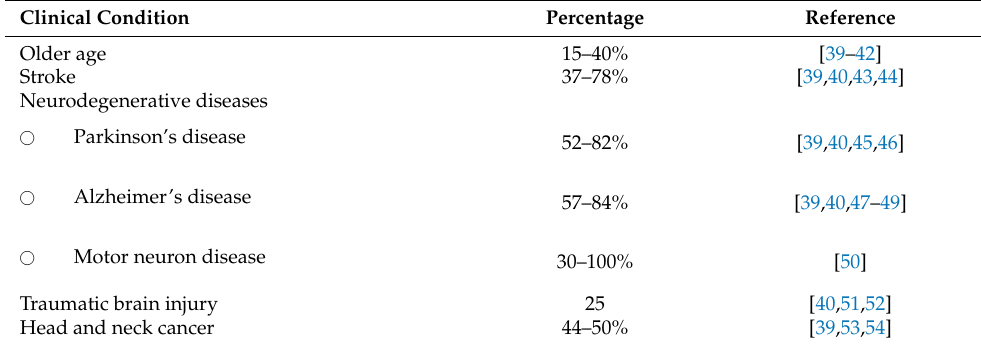
Table 2. Prevalence of oropharyngeal dysphagia in different settings and